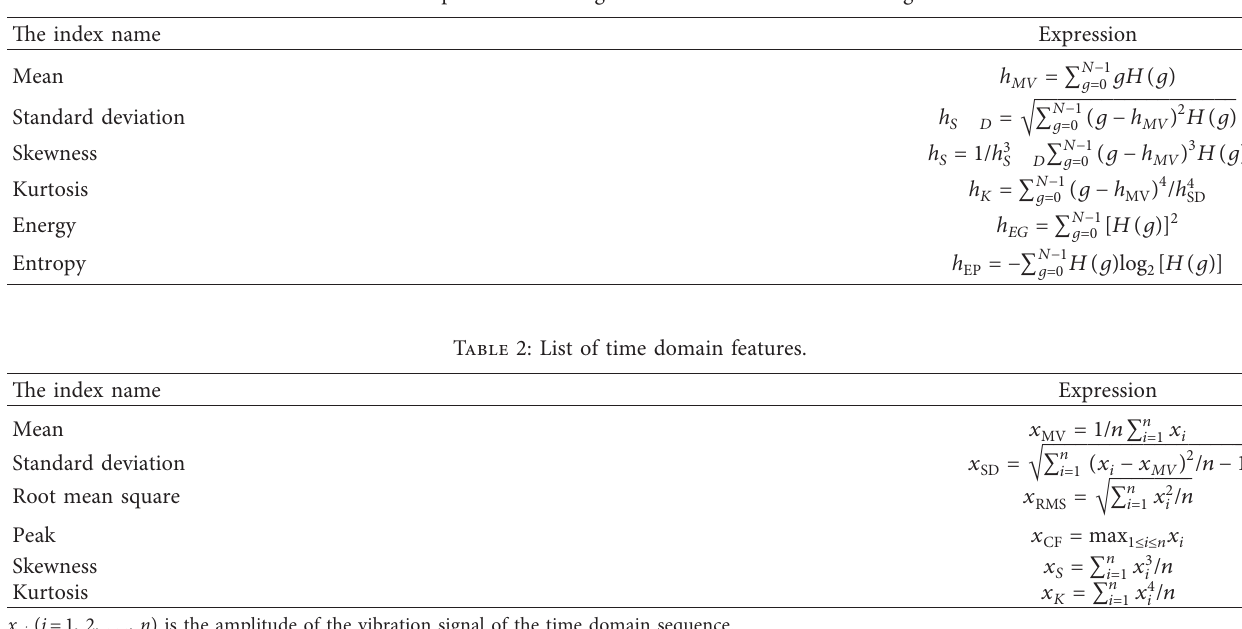
Figure 6: Acquisition of sensitive areas of infrared images. (a) Original image. (b) Image segmentation. (c) Extraction of sensitive areas. Table 1: Expression of histogram features of the infrared image.